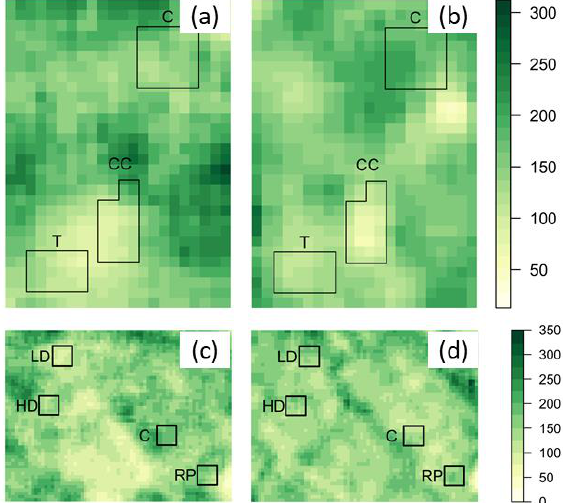
Figure 8. Spatial distribution of AGB between plots in different forests. Boxplots show the distribution of the plot measurements within a site for the field measurements (black) and the distribution of the estimate pixel AGB for each specific model within the bounds of the site. The blue boxplots represent the S1 seasonal mean model with VH and VV; the red boxplots represent the Palsar2 model using the Alpha and Pv parameters. Top: Shows MAS and LOVE where multiple treatment sites exist in addition to the reference site (C). Bottom: shows HAR, KING, MIL, and MOORE, which only have paired sites, a control or reference, and a treatment.